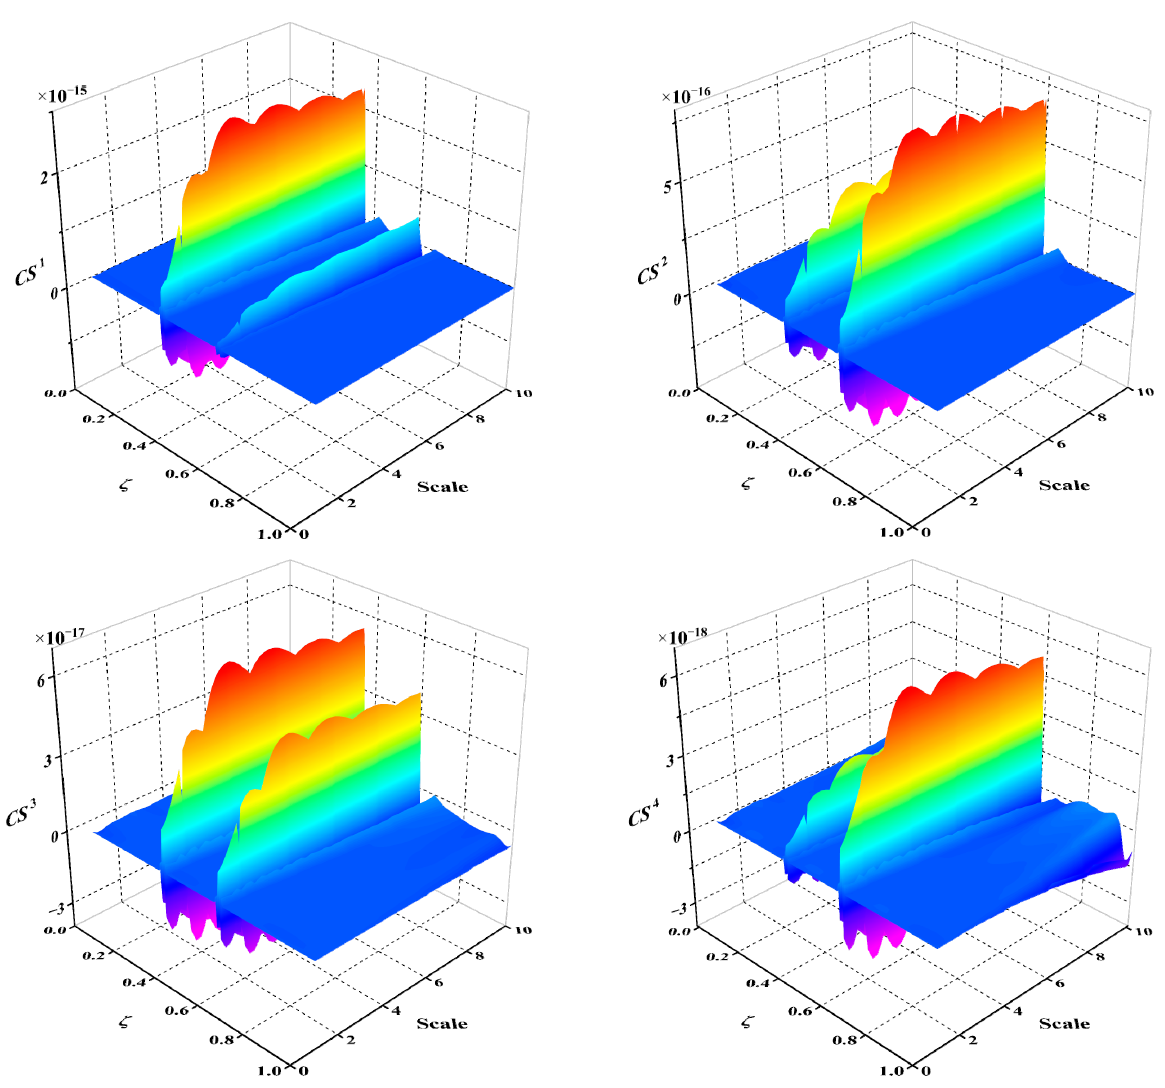
. Figure 13. Damage identification results under scenario I: ( a ) CS ( b, s ) ; ( b ) Damage index SSSM DI . DI